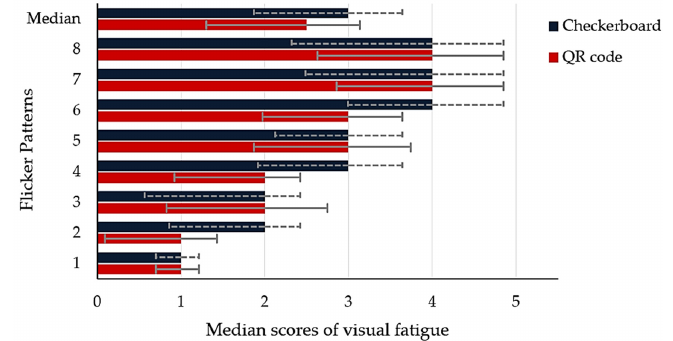
Figure 12. Visual fatigue scores from all participants, after performing the QR code and checkerboard stimulus patterns, with different flicker stimuli, with 95% confidence intervals.